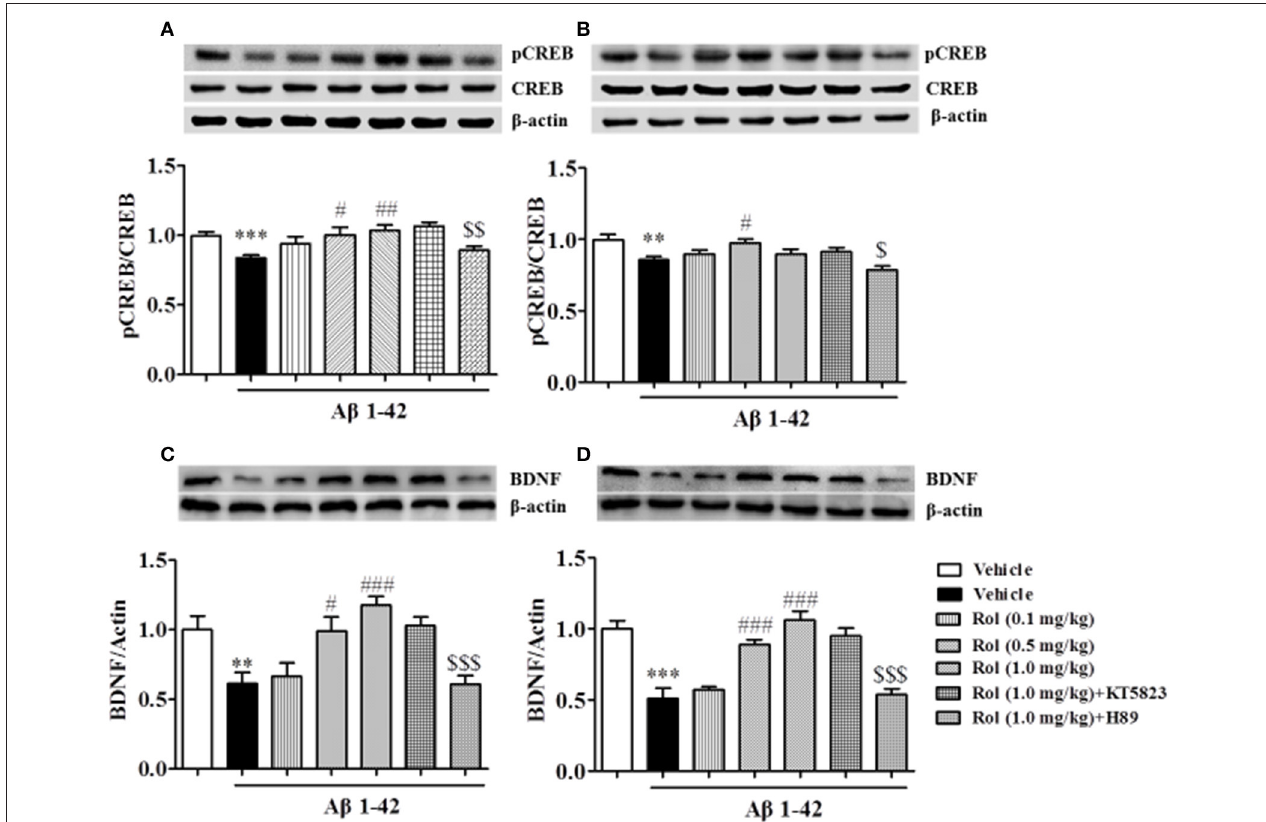
FIGURE 7 | The effects of rolipram on A β -induced changes in the ratio of pCREB to CREB and BDNF expression in the hippocampus (A,C) and the cortex (B,D) of mice. Values shown are means ± SEM, n = 10; ** p < 0.01 and *** p < 0.001 vs. vehicle-treated control group. # p < 0.05, ## p < 0.01 and ### p < 0.001 vs. vehicle-treated A β group. $ p < 0.05, $$ p < ,0.01 and $$$ p < 0.001 vs. rolipram (0.5 or 1.0mg/kg)-treated A β group.